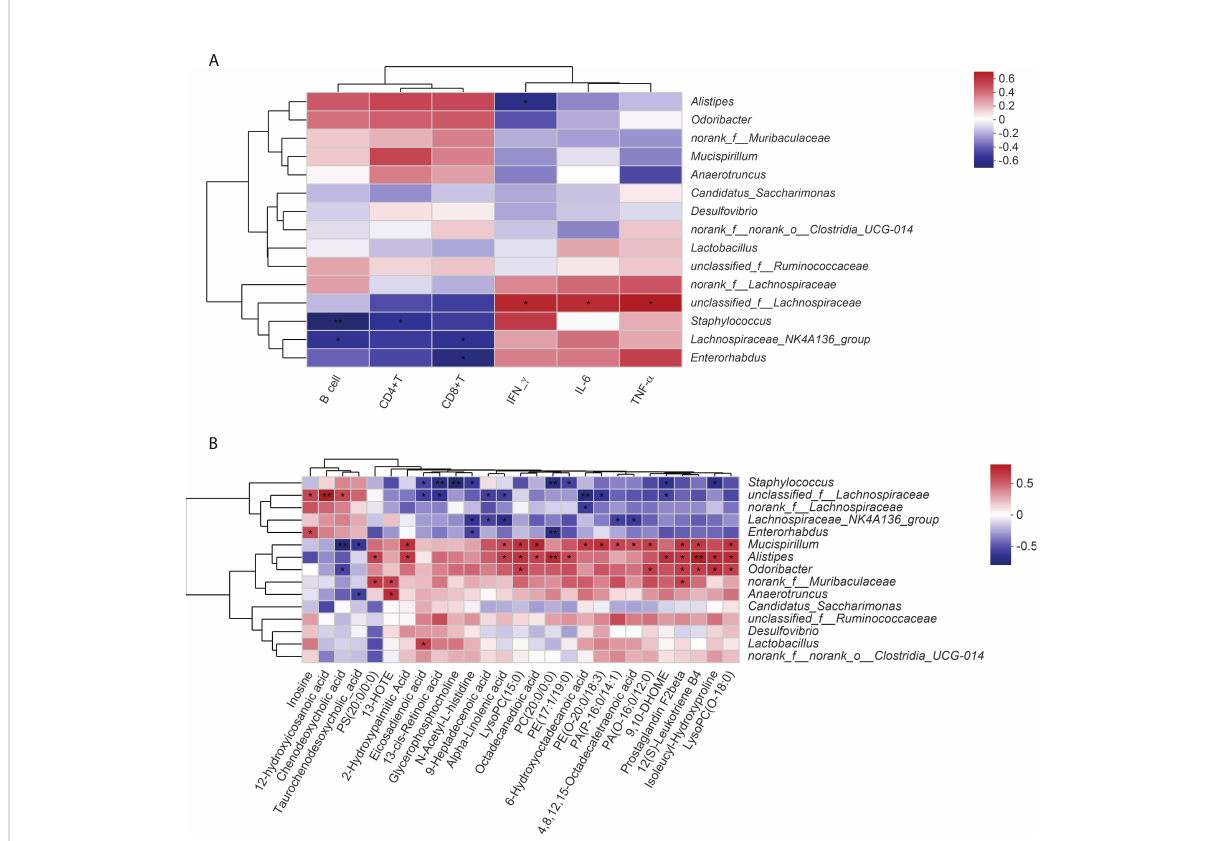
FIGURE 6 Spearman correlation analysis. (A) Correlation analysis of the gut microbiota with immune and in fl ammatory indicators. (B) Correlation analysis of the gut microbiota with serum DMs. Signi fi cance levels are indicated as follows: *, p < 0.05; **, p <